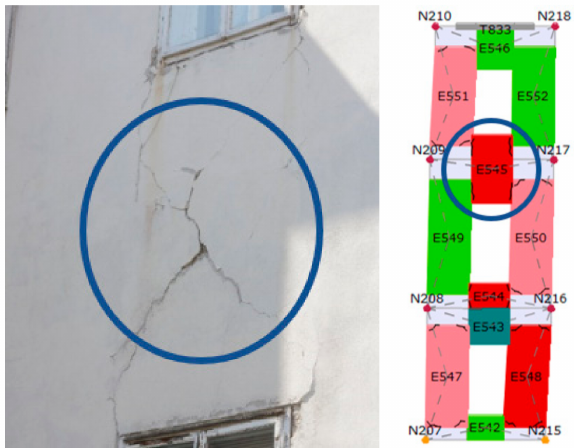
Figure 25. Comparison of the damaged spandrel (Eastern façade).